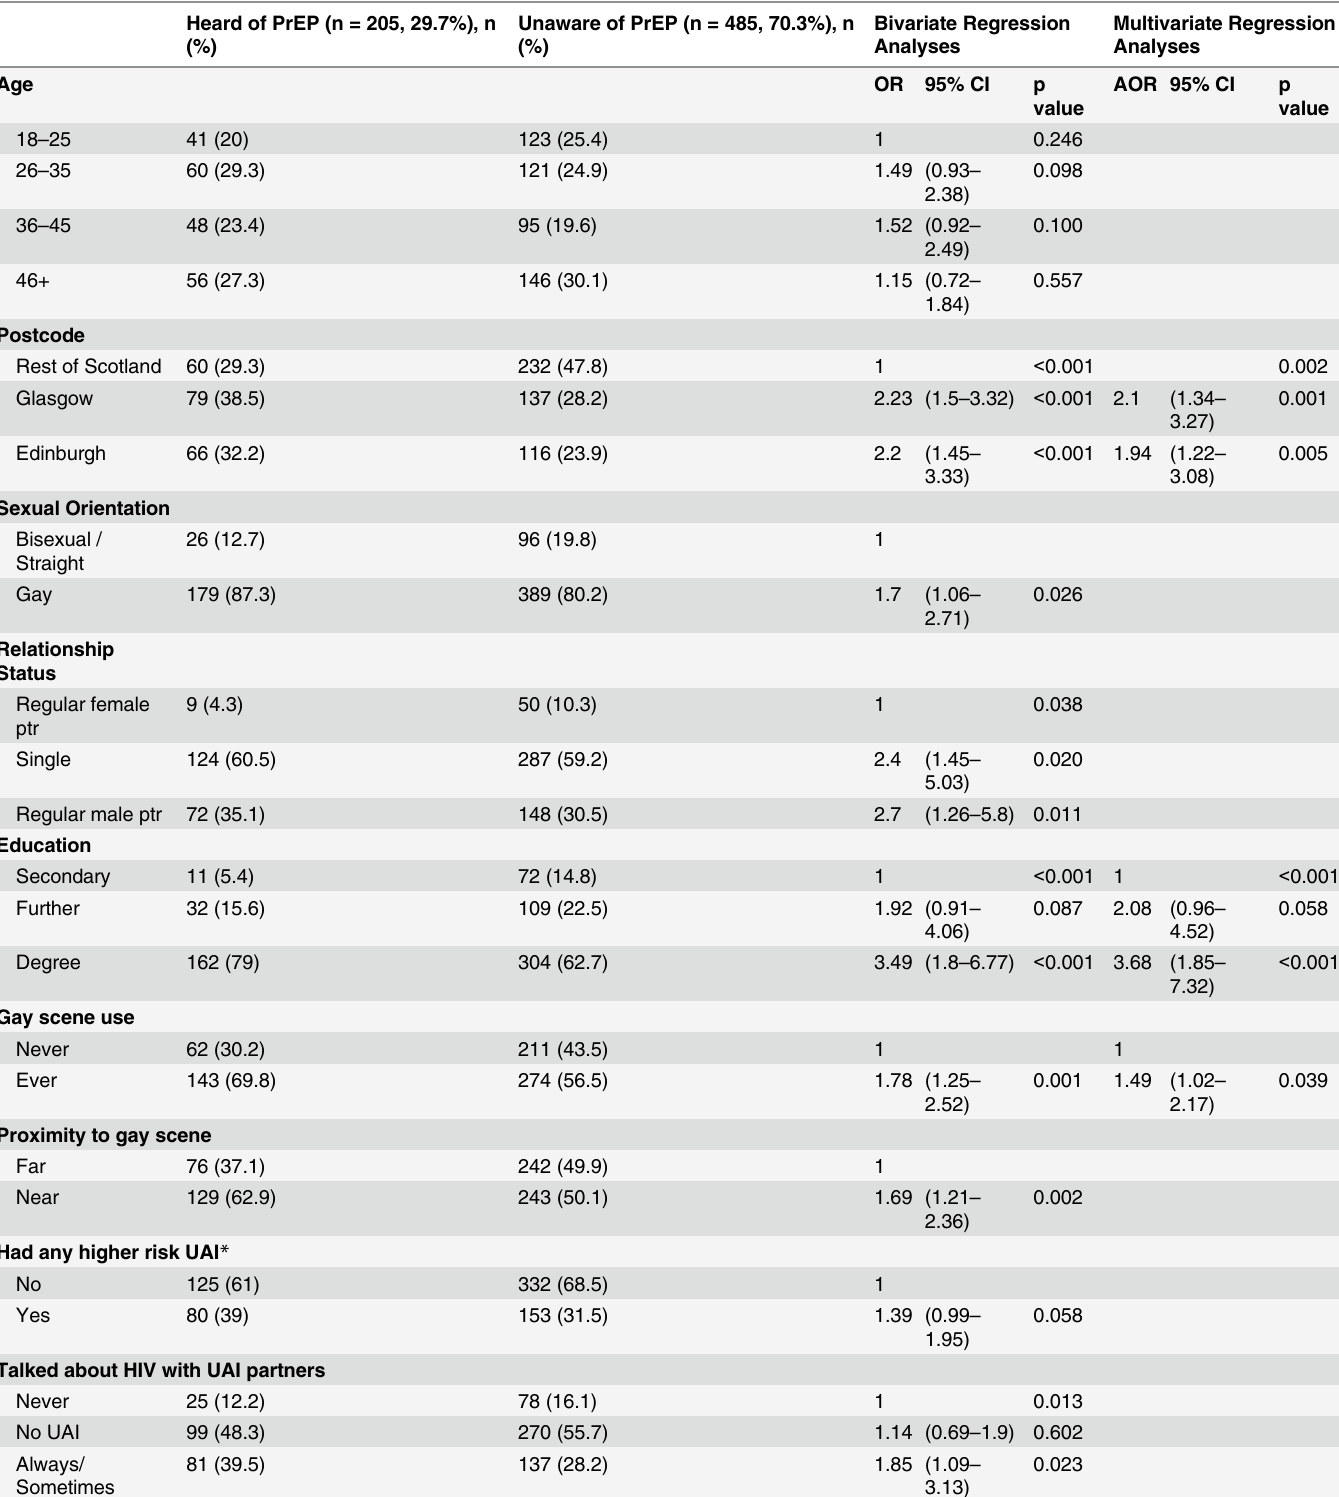
Table 2. Factors associated with Awareness of PREP (N =